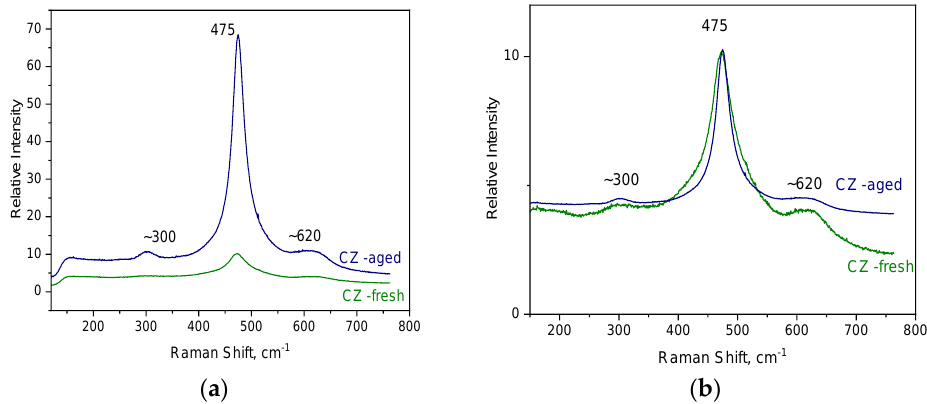
Figure 1. ( a ) Raman spectra of the CZ support material fresh and aged ( b ) same spectra normalized with respect to main peak.